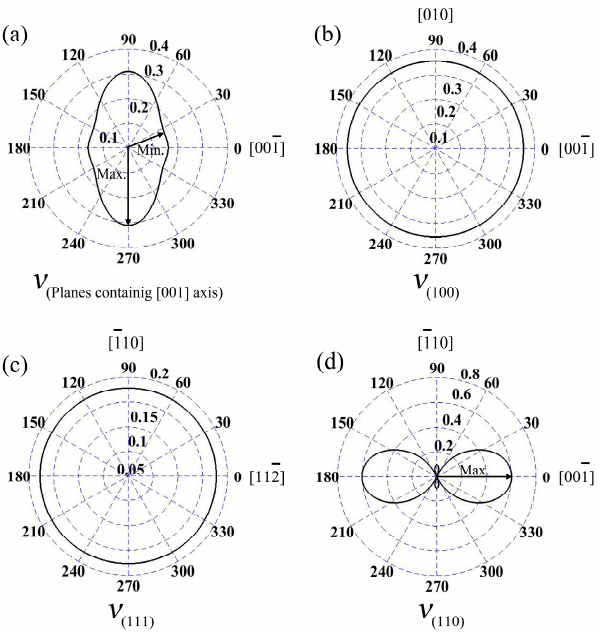
Figure 4. Poisson’s ratios v for the planes containing [001] ([0001]) axis in the wurtzite GaN ( a ); and three low index planes (100) ( b ); (111) ( c ); and (110) ( d ) in the zinc-blende GaN.